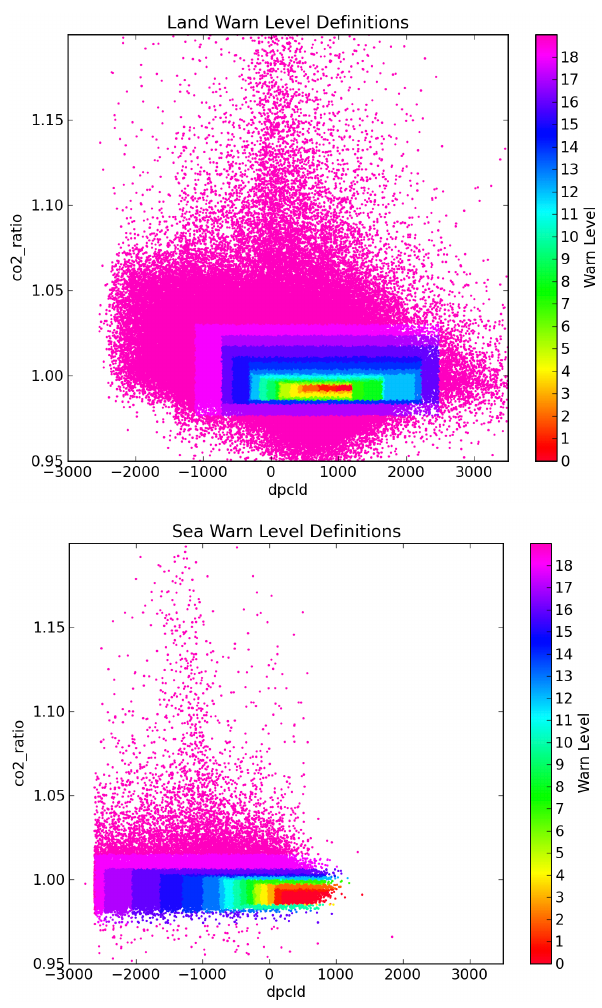
Figure 14. The definition of warn level as a function of CO2r and dPc. The optimal values of CO2r ~ 0.99 and dPc ~ 800 hPa are different from 1.0 and 0.0 due to imperfect spectroscopy.